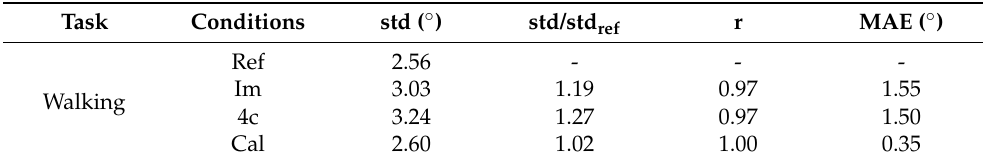
Table 3. Summary of angles statistics, averaged for all joints. Each condition is represented: reference condition (Ref), degraded image quality (Im), four cameras instead of eight (4c), degraded calibration (Cal). Comparisons between each Im, 4c, Cal conditions, and Ref are accounted for with standard deviation (std), the standard deviation ratio (std/std ref ), the Pearson’s correlation coefficient (r), and the mean absolute error